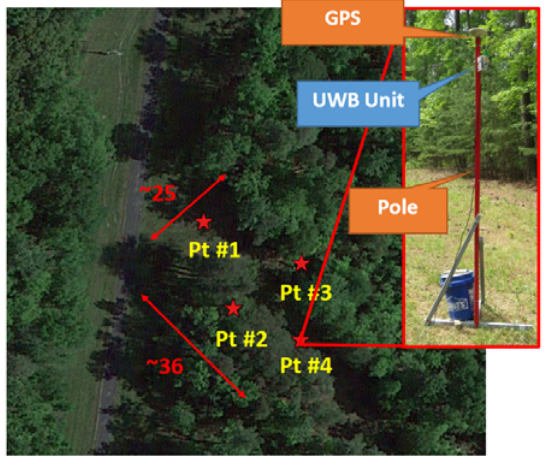
Figure 5. Canopied test site and UWB network